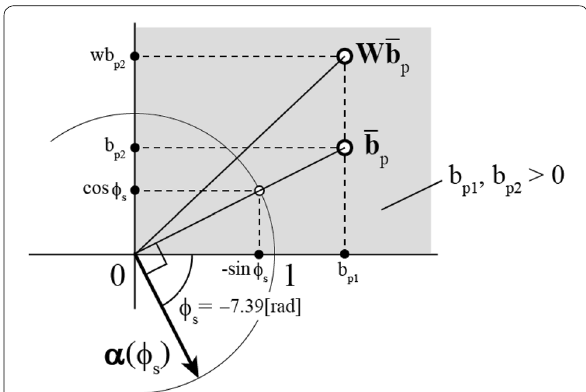
Fig. 13 Linear transformation of vector ¯ b p with weighting matrix W for correction of the feature value R 1